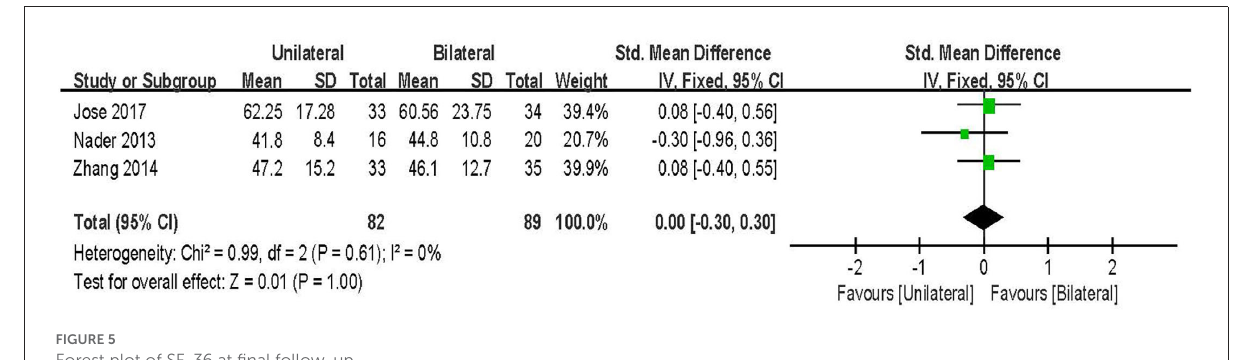
FIGURE5 Forest plot of SF-36 at final